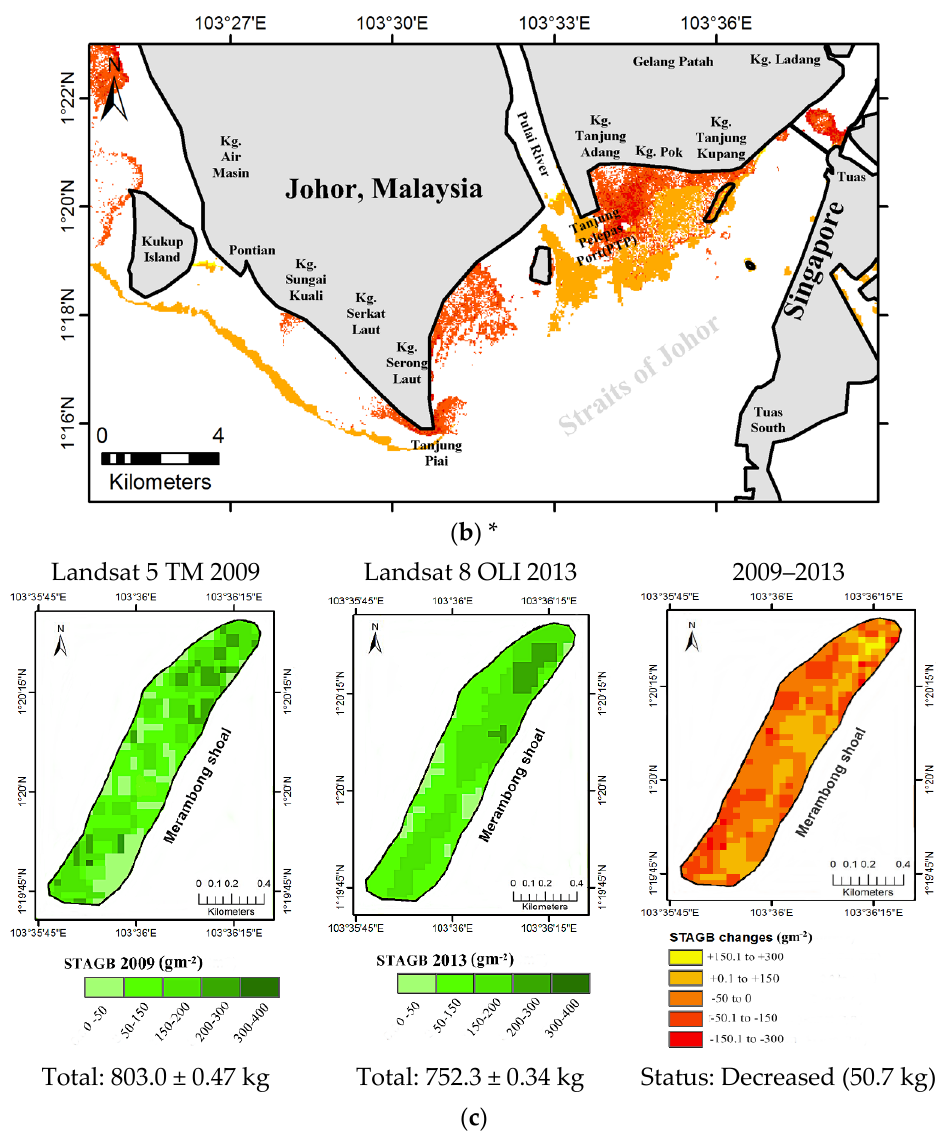
Figure 8. ( a ) STAGB distribution map for 2009 ( left ) and 2013 ( right ); ( b ) STAGB changes between 2009 and 2013; and ( c ) zoomed-in view of STAGB changes for Merambong shoal. * Note: Please refer legend in ( c ). y = -2x10 -05 x 2 + 0.2332x + 3.1719 p ≤0.001 R² = 0.9905 n=36